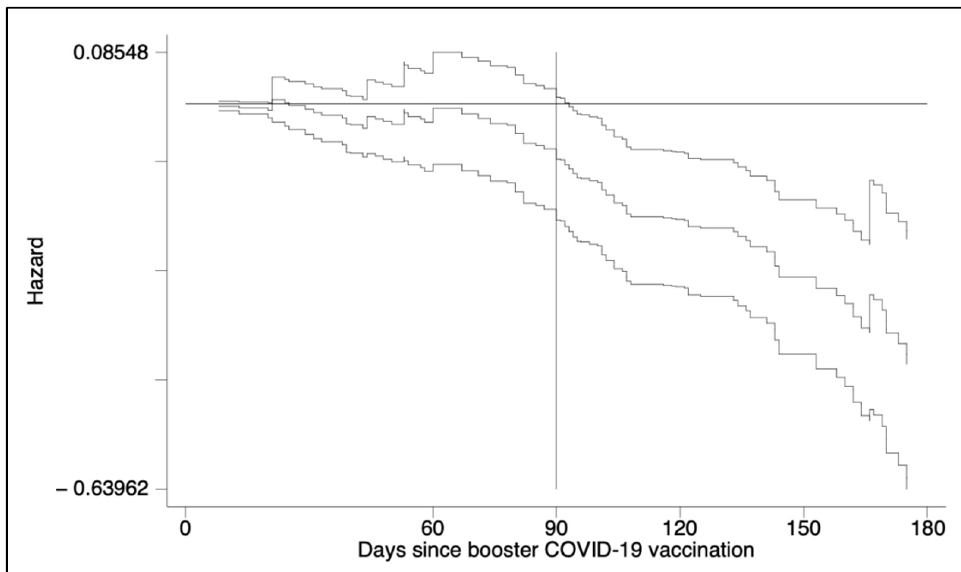
Figure 3. Results from Aalen’s additive regression model for censored data to the Cox regression. The plot shows how the effect of the covariate of interest (i.e., hybrid immunity) changed over time. The y -axis displays the baseline hazard (Intercept 0) at reference value of the covariate and the additive contributions of the time-varying difference from reference value to the hazard of breakthrough infection. Table 3. Characteristics of the breakthrough infection in the study population (N =